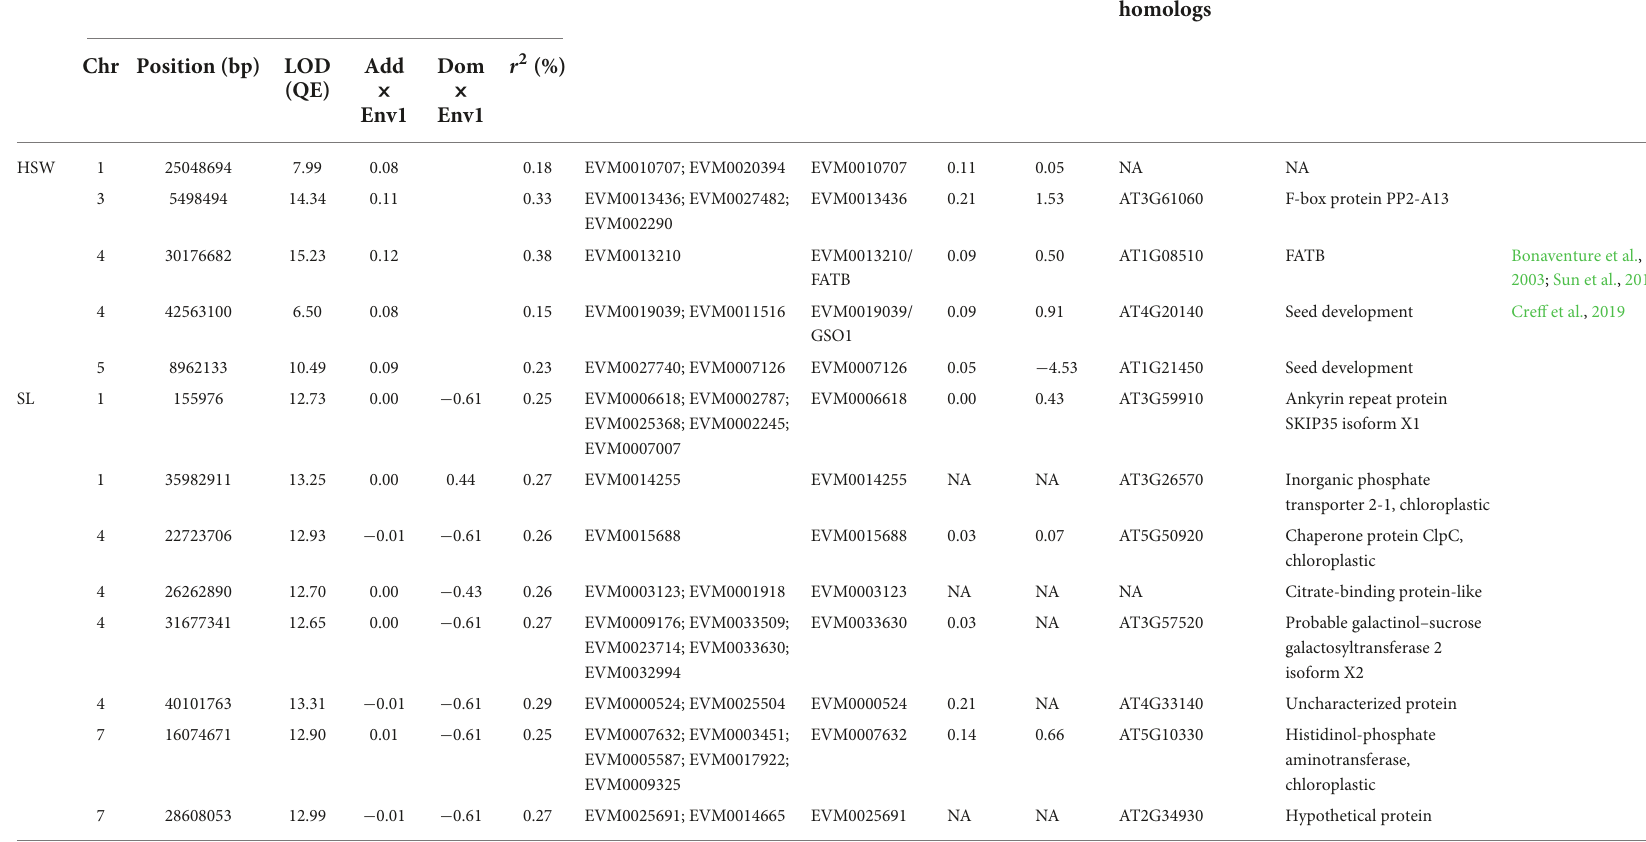
TABLE 2 Twenty significant QTN-by-environment interactions for seed-size-related traits under multi-environments.